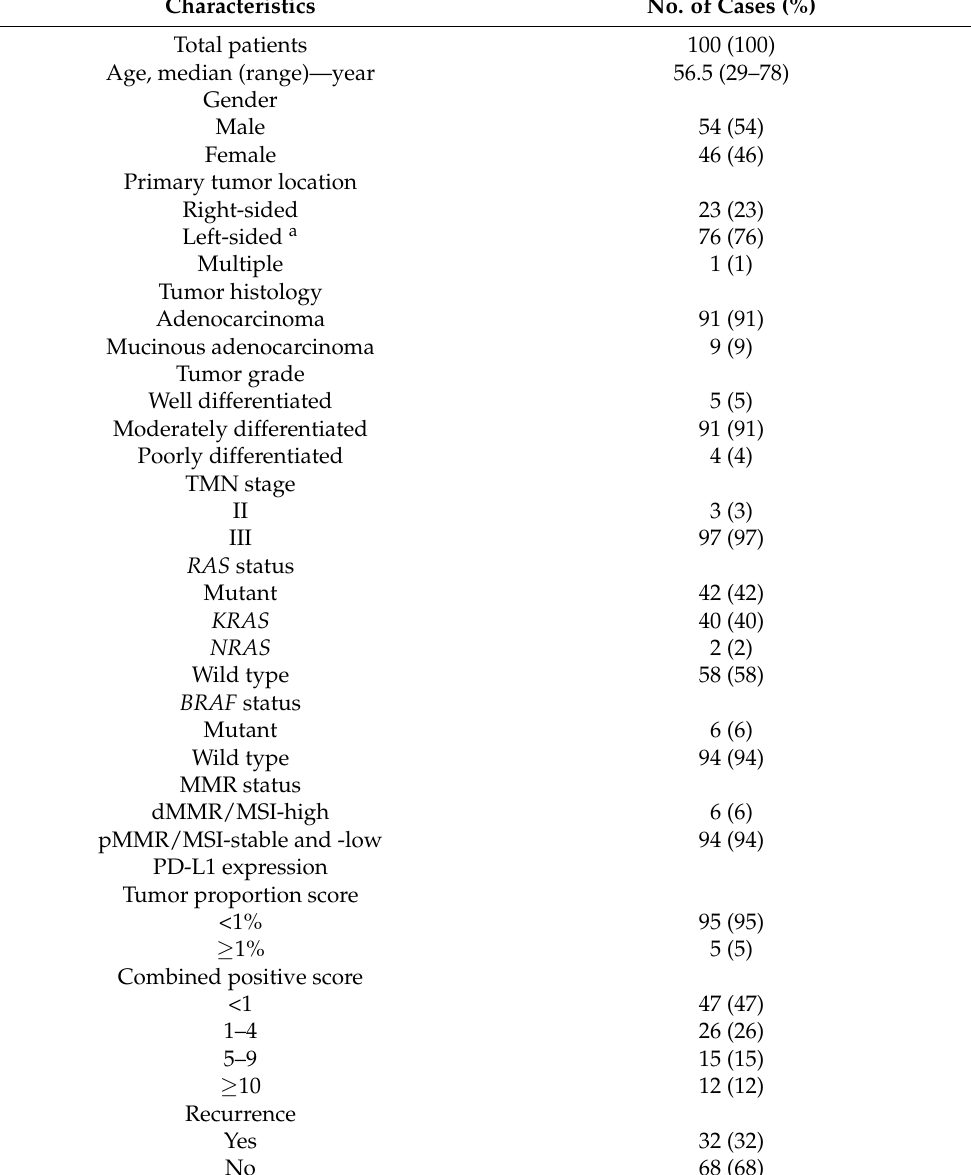
Table 1. Clinical characteristics of 100 CRC